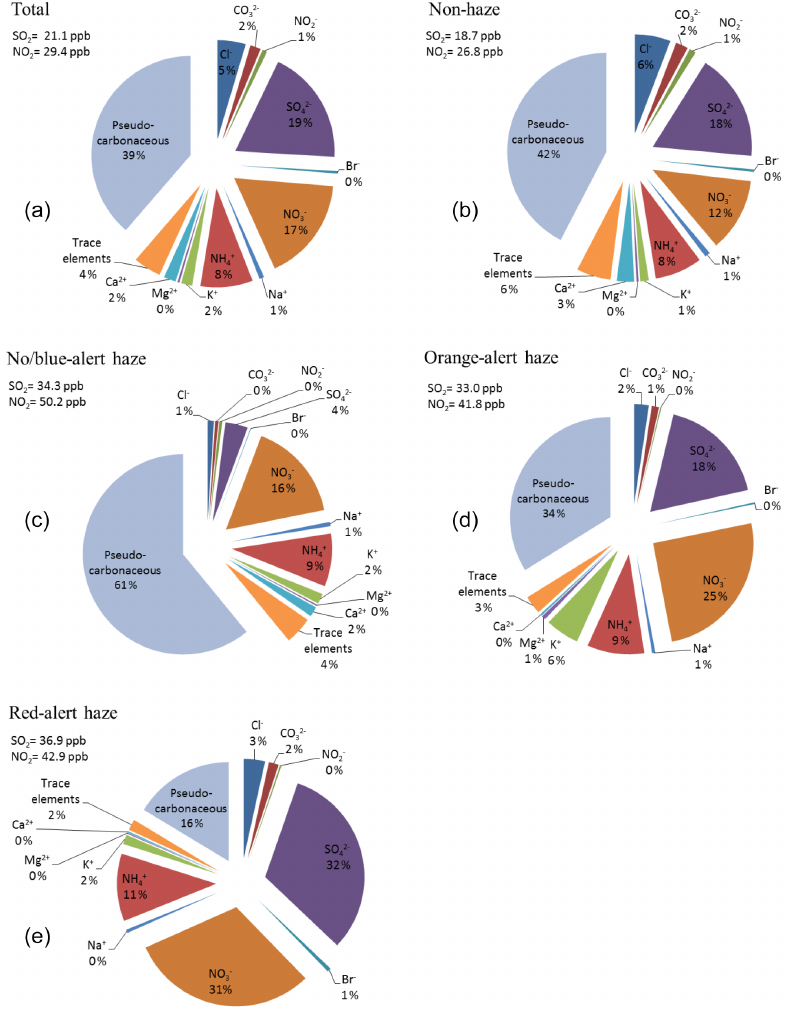
Figure 2. PM 2 . 5 mass contributions of water-soluble ions, trace elements, and pseudo-carbonaceous matter during the entire period (a) , non- haze days (b) , and haze days at blue-alert (c) , orange-alert (d) , and red-alert (e) warning levels. The average SO 2 and NO 2 concentrations are also